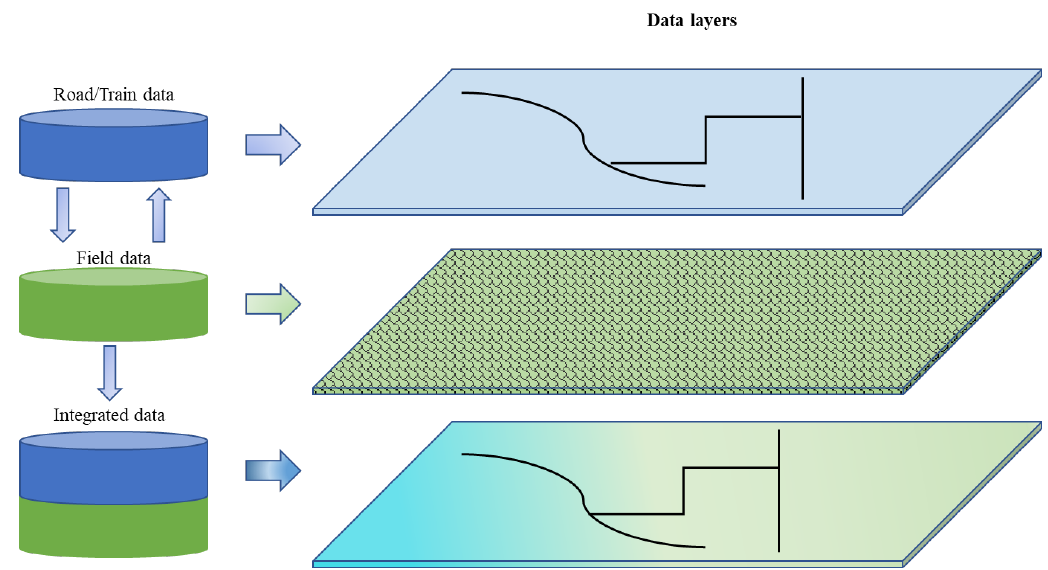
Figure 2. Integrated data